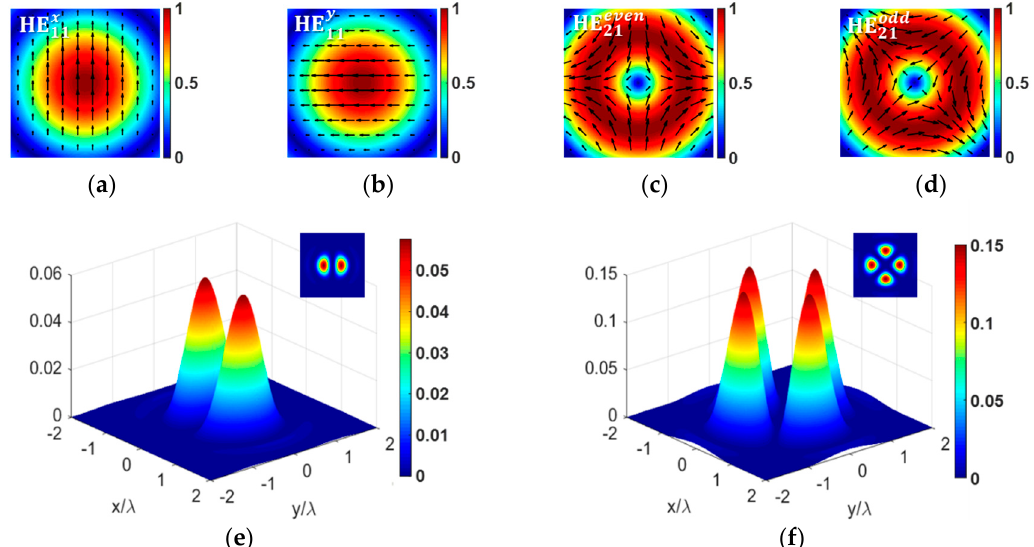
Figure 1. ( a – d ) Modal intensity distributions of HE x / y polarization directions; ( e , f ) calculated longitudinal electric field components of HE x modes under condition of tight focusing.